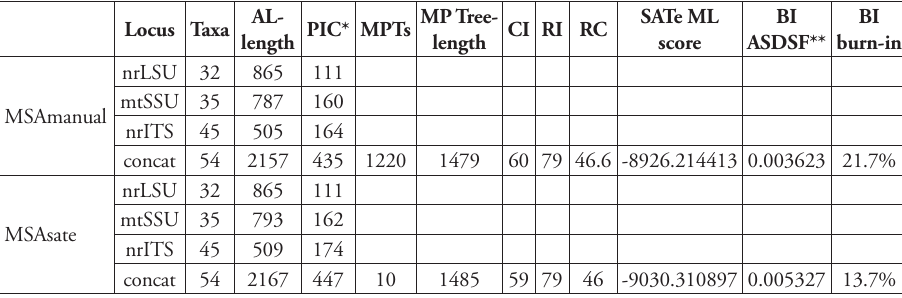
Table 2. Tree statistics from various phylogenetic analyses (MP, ML, BI) of the MSAmanual and MSA- sate